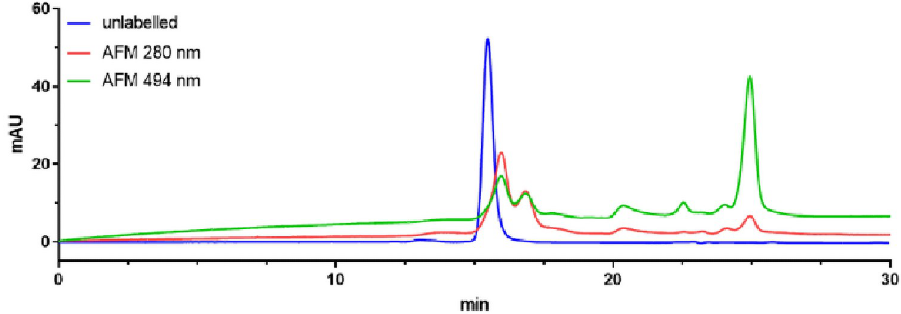
Fig 5. SEC of mAbB2 (Alexa Fluor 488-maleimide), denatured with 0.1% formic acid. Blue line: unlabelled mAb B showed a single peak. Red line: absorbance of modified mAb6 at 280 nm. Green line (494 nm) showed several peaks that indicate (labelled) protein